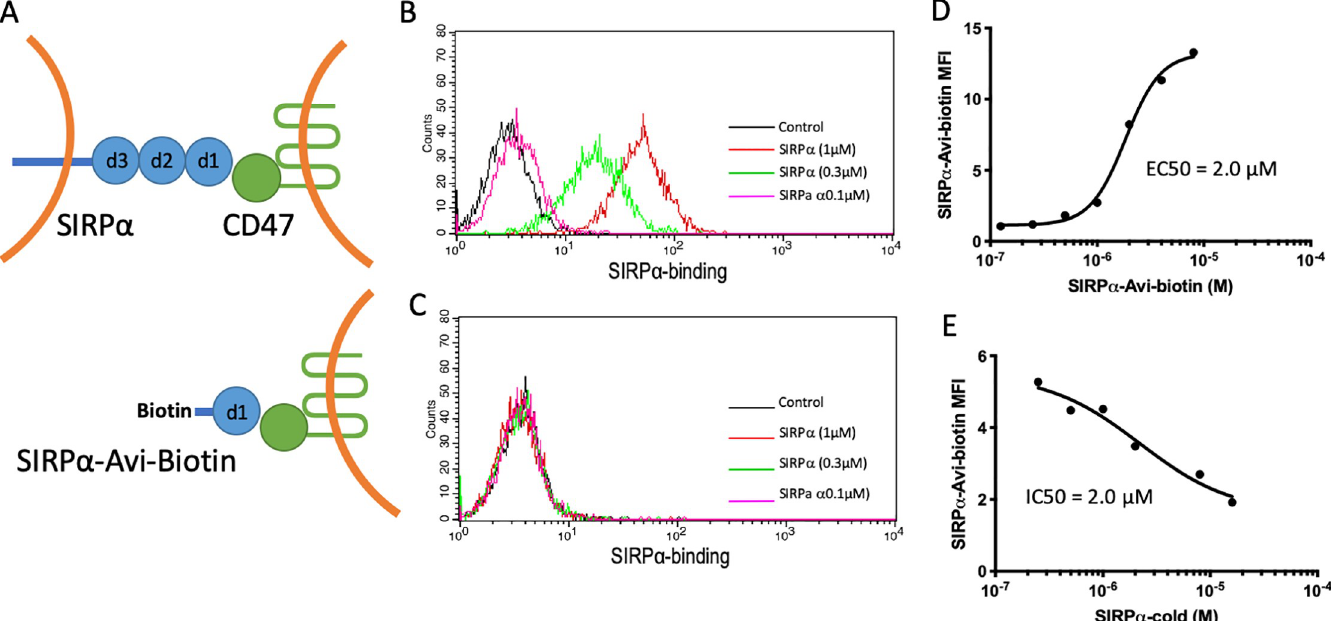
Fig 1. SIRP α specifically binds to CD47 on Jurkat cells (A) Schematic of the SIRP α extracellular domains (d1, d2, d3) and the soluble, biotin-conjugated, CD47-interacting SIRP α (d1) construct used in these studies (SIRP α -Avi-biotin). Flow cytometry histograms showing the concentration-dependent binding of SIRP α to (B) CD47(+) or (C) CD47(-) Jurkat cells imaged using Alexa-488 conjugated streptavidin. Control indicates cells treated with SAV-488 alone (no SIRP α ). (D) Concentration response plot showing the calculated EC50 of SIRP α binding to CD47(+) Jurkat cells. (E) Concentration-dependent inhibition of SIRP α binding to CD47 (+) Jurkat cells by SIRP α -cold (no